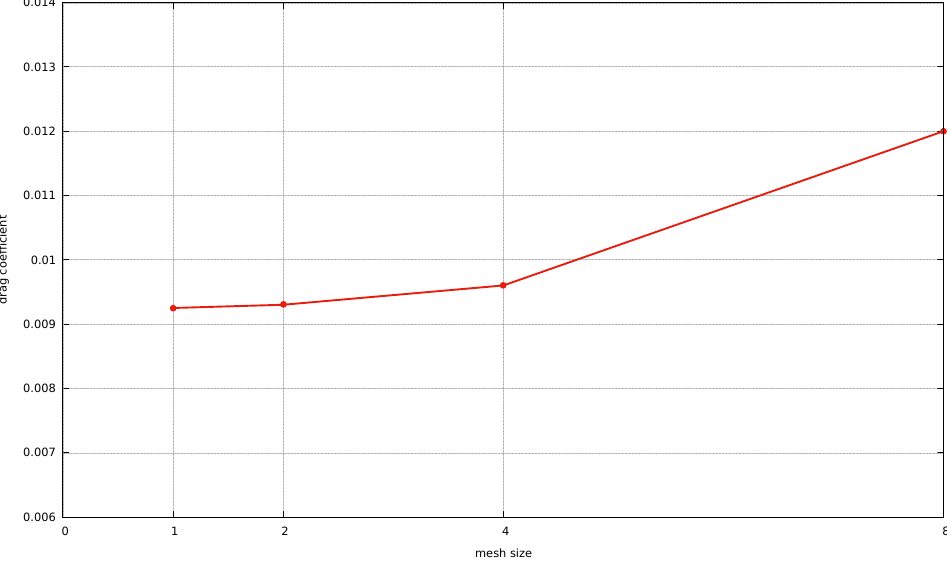
Figure 3. Grid dependency study: computed drag coefficients versus mesh size